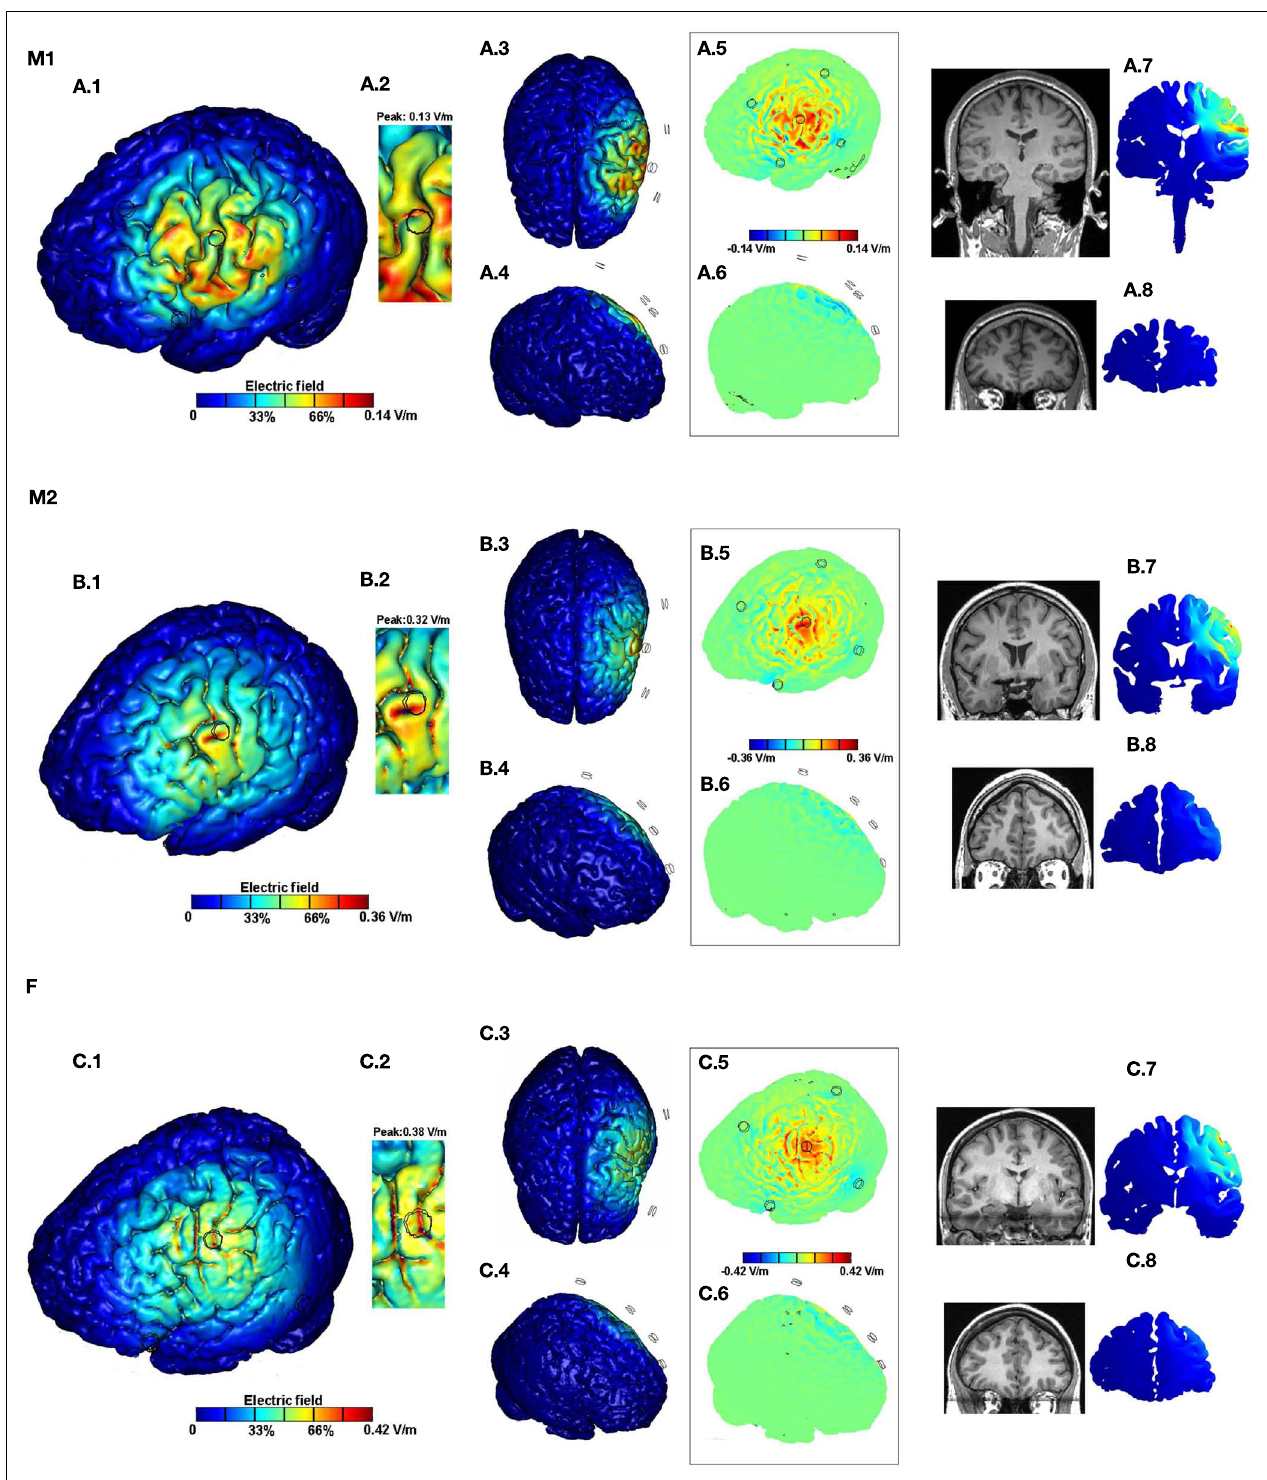
current flow (A.2,B.2,C.2) .The boxed images show the directional plots (A.5,A.6,B.5,B.6,C.5,C.6) . Sample cross-section EF magnitude plots were taken for the frontal and the motor regions. The corresponding MRI scan collected for the subject and the cross-section plots are shown juxtaposed to each other (A.7,A.8,B.7,B.8,C.7,C.8)